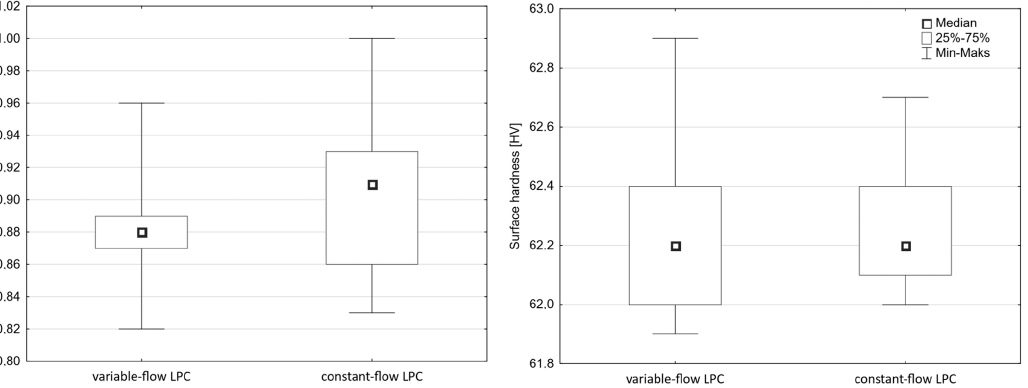
Figure 5. The depth of the hardened case of parts resulting from variable-flow and constant-flow processes (LSL, USL—lower and upper specification limit).